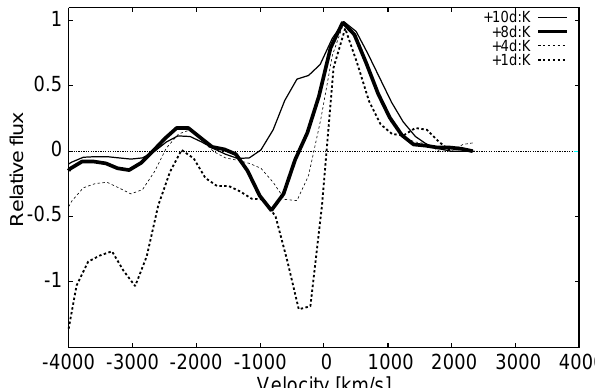
Figure 4: Temporal change of the P Cygni profile for O I (7774 ˚A at rest) emission line before the brightness maximum. The measured ejection velocites based on the P Cygni profiles were 630 km/s (at t=2d), 640 and 750 km/s (at t=5d), and 1150 km/s (at t=9d). Rudy et al. (2012) reported the detection of CO molecular emission in the near-infrared spectra taken on 2012 Oct 27 and 28 UT (before the brightness max- imum), indicating that molecule formation was ongo- ing, with dust formation likely to follow. Nova V1724 Aql was probably a slow nova that showed CO emis- sion during the pre-maximum halt (at least, before the maximum). However, there were no hints for C 2 and CN absorption bands in optical spectra of the nova